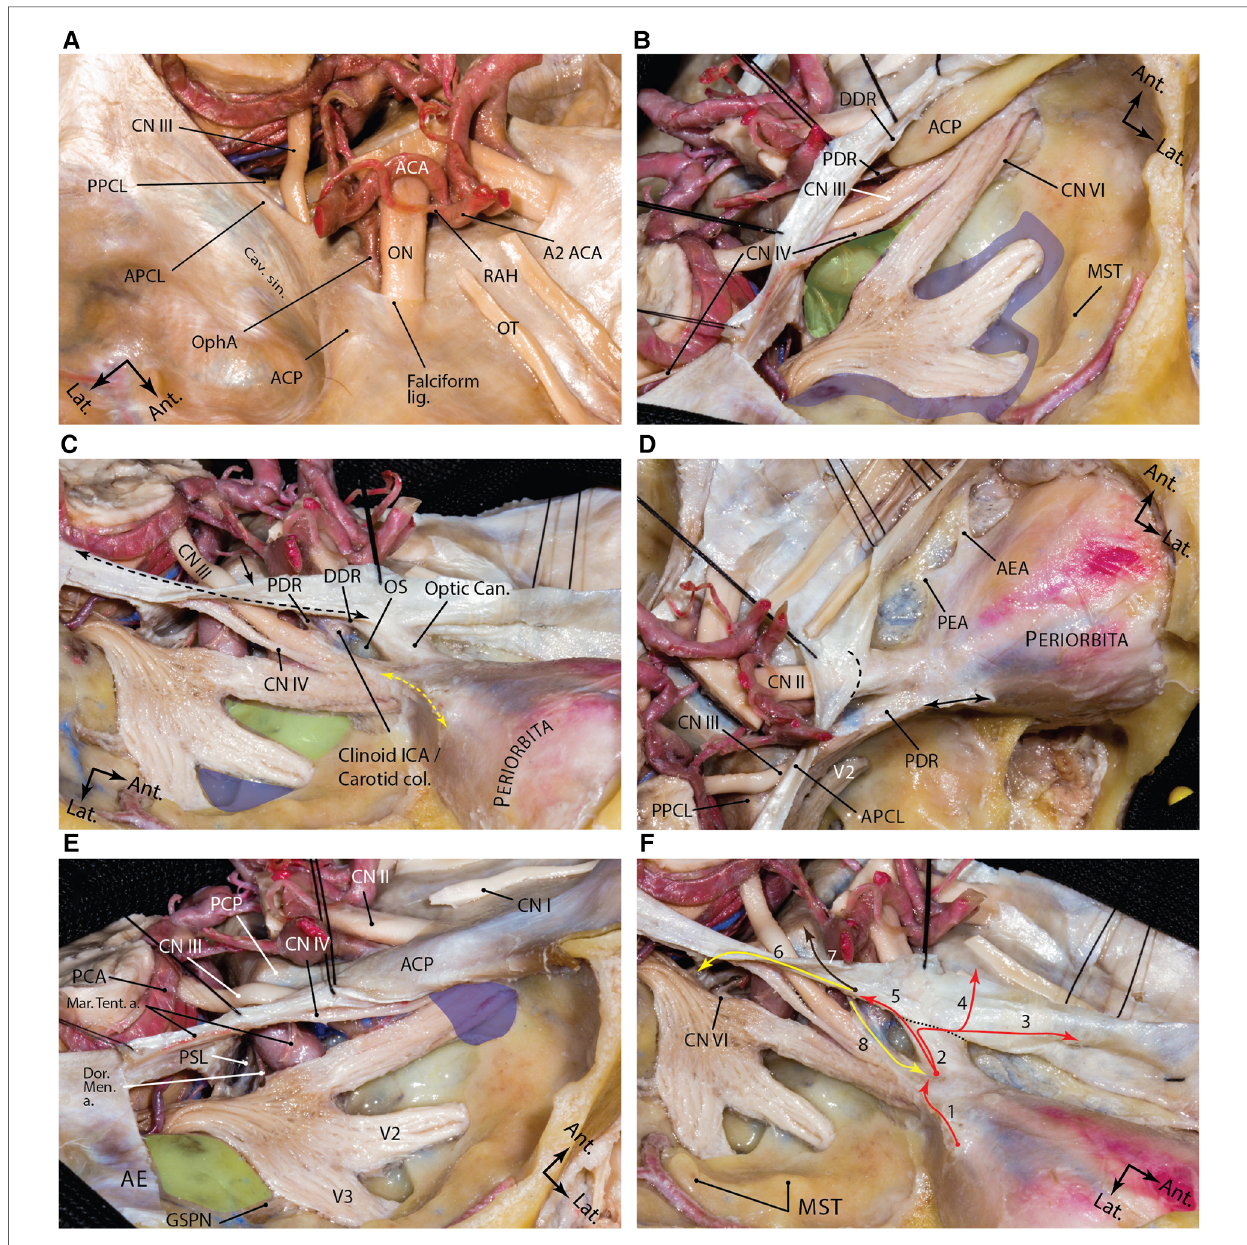
FIGURE 6 Dural anatomy of the middle fossa. ( A ) exposure of the middle fossa dura and its relationship with the dura and anatomic structures of the central skull base. ( B ) The meningeal and endosteal layers of the dural covering of the middle fossa are removed to expose the relevant neural relationships. Lifting the dura over the anterior clinoid process and along the lateral wall of the cavernous sinus. The proximal and distal dural rings are dural layers surrounding encompassing the anterior clinoid process. One may appreciate how trochlear nerve pierces the medial tentorial edge and enters the roof of the cavernous sinus. Meckel ’ s cave ori fi ce which is composed of meningeal layer of dura is widened around the trigeminal nerve root. This layer continues anteriorly as the roof of the cavernous sinus under the anterior clinoid process as the proximal dural ring. The green shaded area shows the Parkinson ’ s triangle (the largest triangle of the cavernous sinus) through which the posterior genu of the cavernous carotid is exposed. The blue shaded area marks the laterotrigeminal venous system region. ( C ) Following anterior clinoidectomy, the relationship between the proximal and distal dural rings is better revealed. These layers converge at the root of the anterior clinoid process and are opened and continue laterally as the meningo-orbital band (dashed yellow double arrow) and anteriorly as the periorbita. Note the re fl ection of the meningeal layer of the dura (black arrow) along the tentorial edge (dashed black double arrow). Green and blue areas show and anteromedial and anterolateral triangles, respectively. ( D ) Upper view of the right cavernous sinus exposure and dural covering of the orbit along the cribriform plate. Black double arrow shows the amputated meningo-orbital band. Dashed line shows the location of the falciform ligament. ( E ) Exposure of the posterior aspect of the cavernous sinus and dural re fl ections around Meckel ’ s cave entrance. Blue area shows the superior orbital fi ssure and green areas shows the middle fossa rhomboid (Kawase ’ s). ( F ) Dural re fl ections in the paraclinoid region. 1, meningo-orbital band; 2, tip of the anterior clinoid process; 3, anterior fossa along the cribriform plate; 4, anterior fossa along the planum sphenoidale; 5, distal dural ring; 6, medial tentorial edge, anterior petroclinoid and petrosphenoid ligaments; 7, interclinoid ligament; 8, proximal dural ring. Black dashed line represents the location of falciform ligament. ACA, anterior cerebral artery; ACP, anterior clinoid process; ant., anterior; APCL, anterior petroclinoid ligament; cav., cavernous; CN, cranial nerve; lat., lateral; lig., ligament; ON, optic nerve; OphA, ophthalmic artery; OT, olfactory tract; PPCL, posterior petroclinoid ligament; RAH, recurrent artery of Heubner; sin., sinus. ( Courtesy of Barrow Neurological Institute. Used with permission